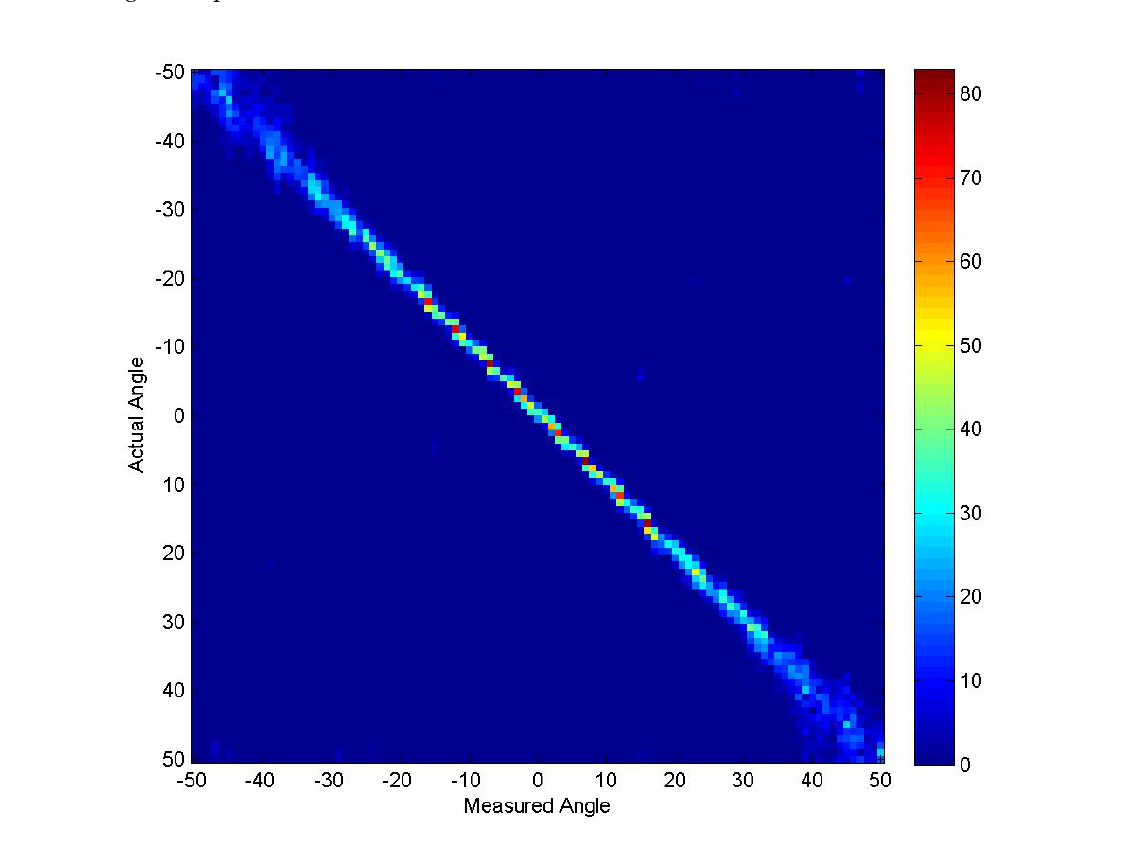
Figure 1. Sample AOA ambiguity